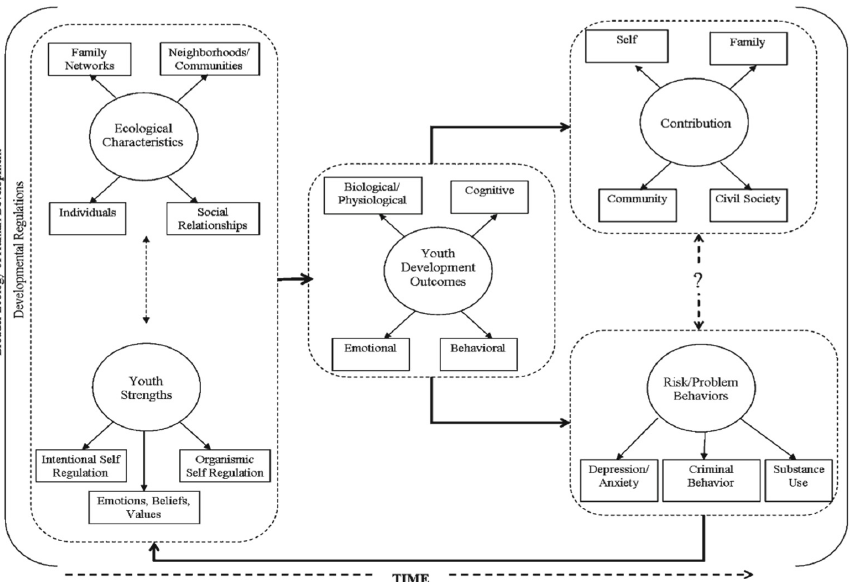
Figure 1. A Relational Developmental Systems model of the individual-context relations in resilience [3].